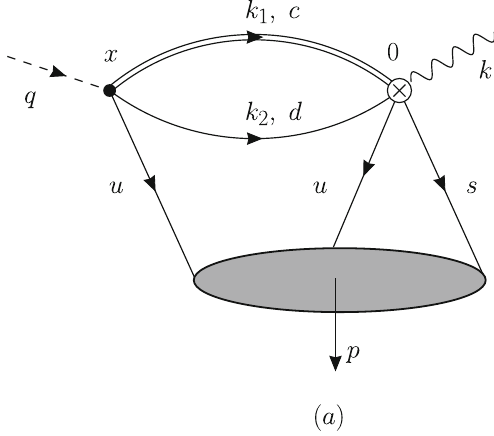
tion where the white crossed dot denotes the current j μ . The black dot denotes the (cid:2) c current. The grey ellipse represents the LCDAs of the (cid:3)